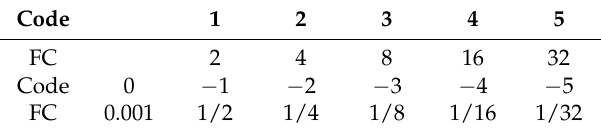
Table 1. Perturbation code and the corresponding fold change (FC) of mutated gene expression. Code